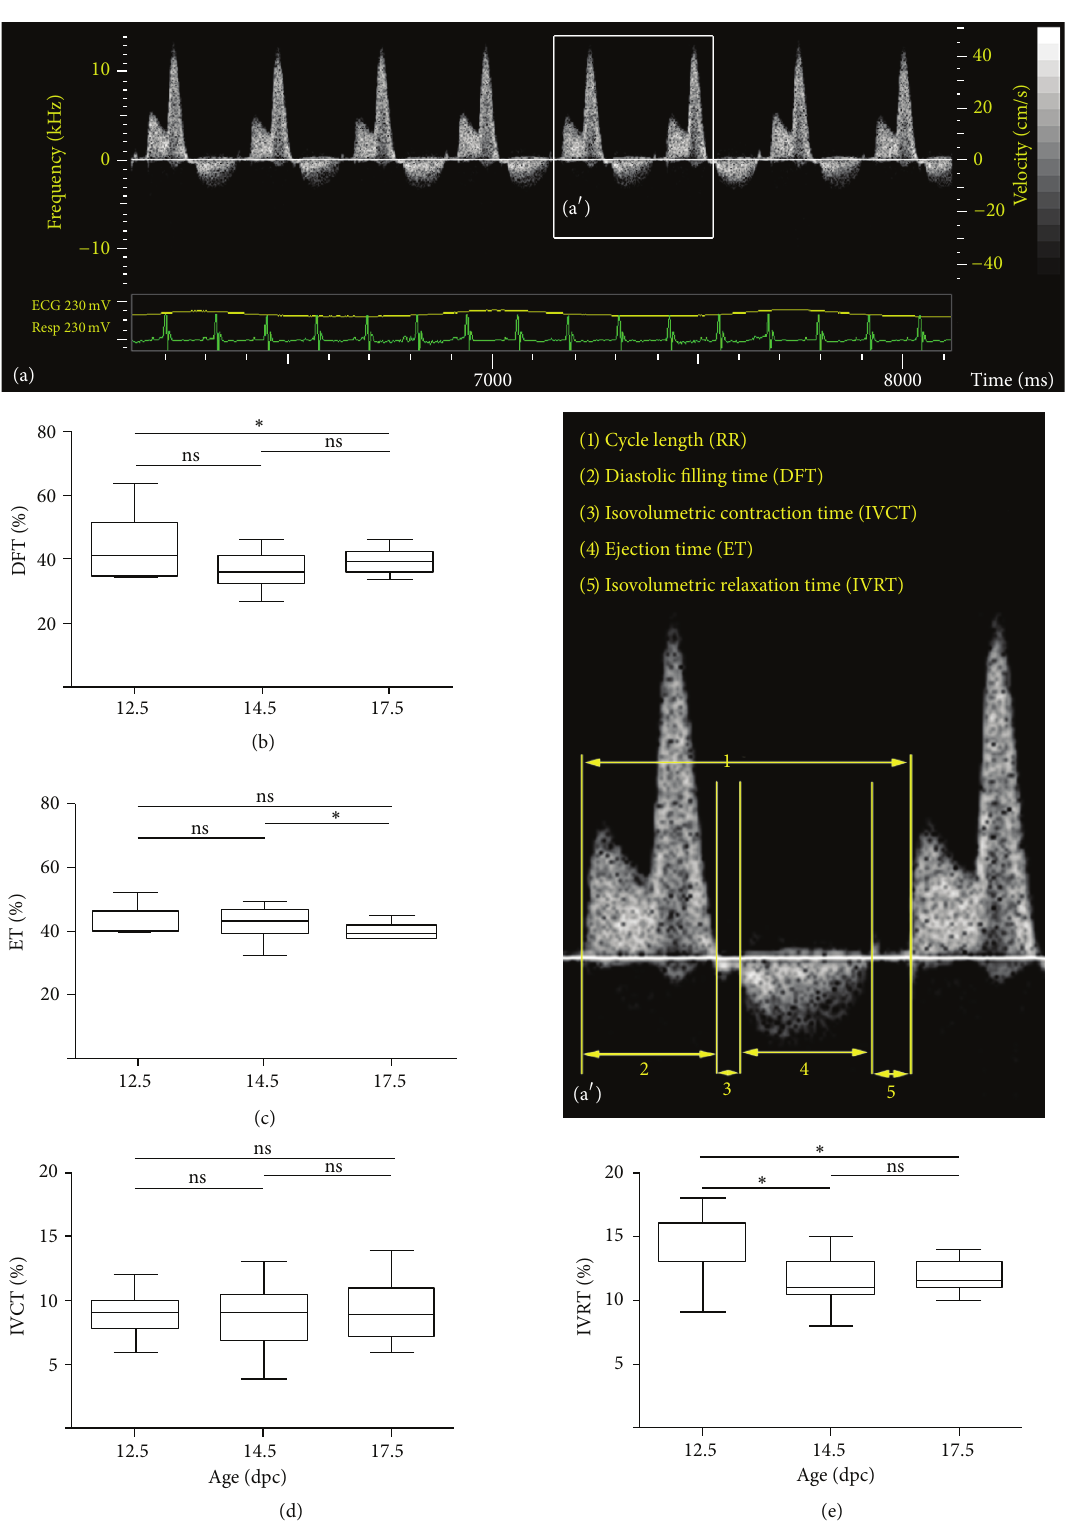
Figure 1: Development of LV inflow patterns. (a) Shows an example of a pulsed-wave Doppler recording across the MV at 17.5 dpc. (a 󸀠 ) Indicates the magnification of the boxed area in (a) in which the individual time intervals are indicated, that is, RR, DFT, IVCT, ET, and IVRT. (b) Through (e) indicates the course of the DFT, ET, IVCT, and IVRT, respectively, throughout embryonic/fetal life. All values in (b–e) are expressed as percentage of the